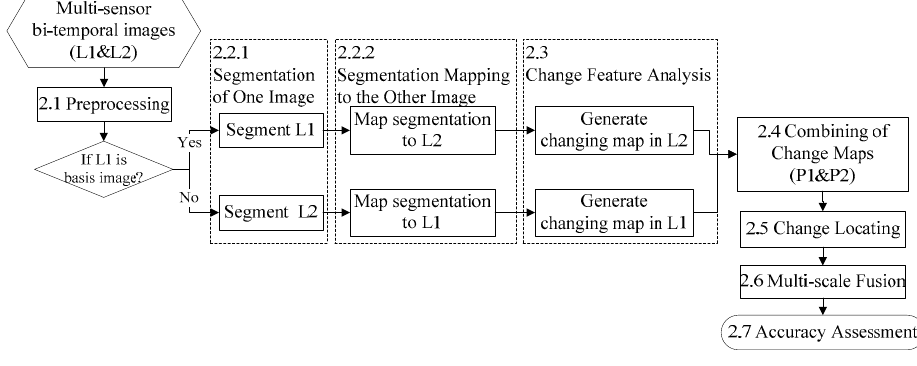
Figure 1. Processing flow of the proposed method.